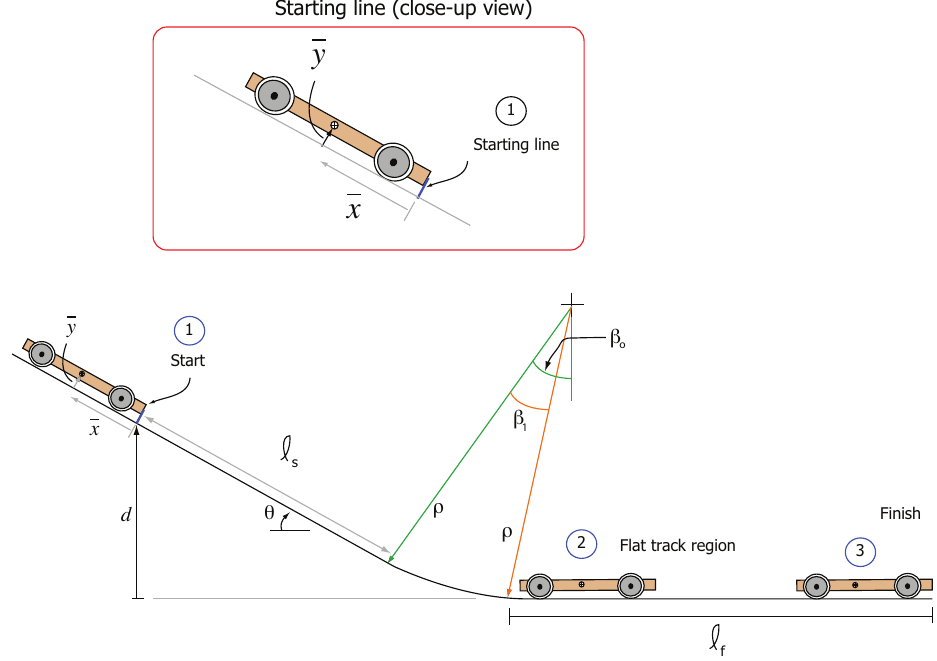
Figure 1. Illustration of a car at the starting line (upper left) with the location of the center of mass marked by ¯ x and ¯ y . Bottom illustration shows the car at several locations along the track and the important track